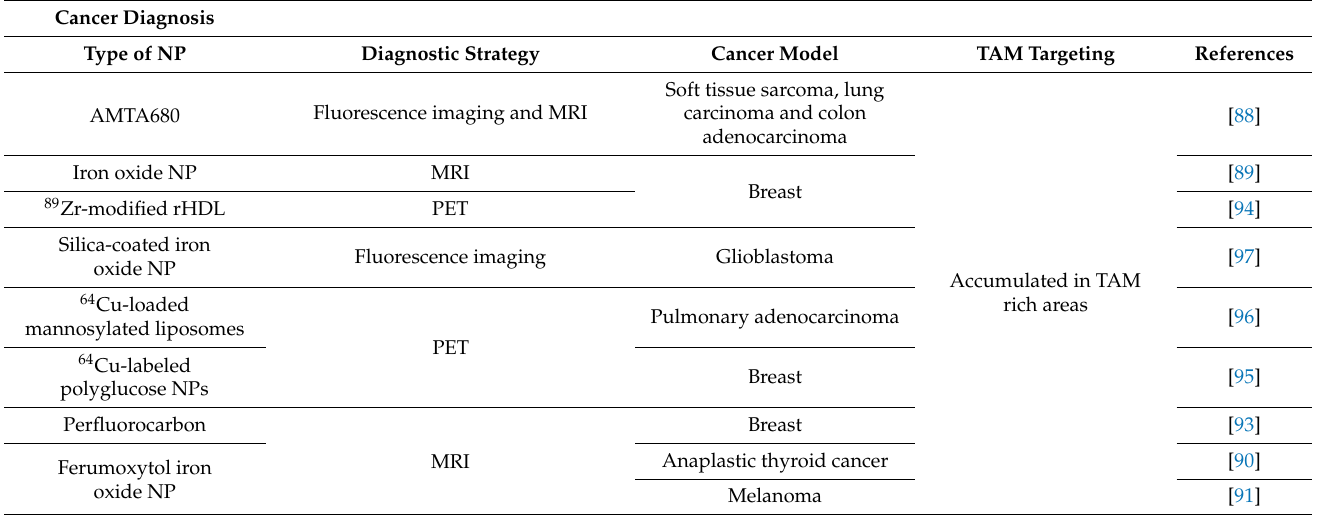
Table 3. Nanoparticle-based strategies targeting tumor-associated macrophages for cancer diagnosis and therapy. Cancer